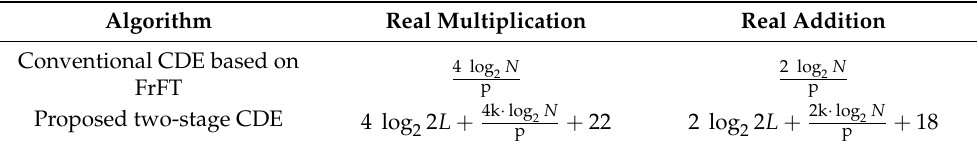
Table 1. Complexity comparison between the proposed and conventional CDE scheme.